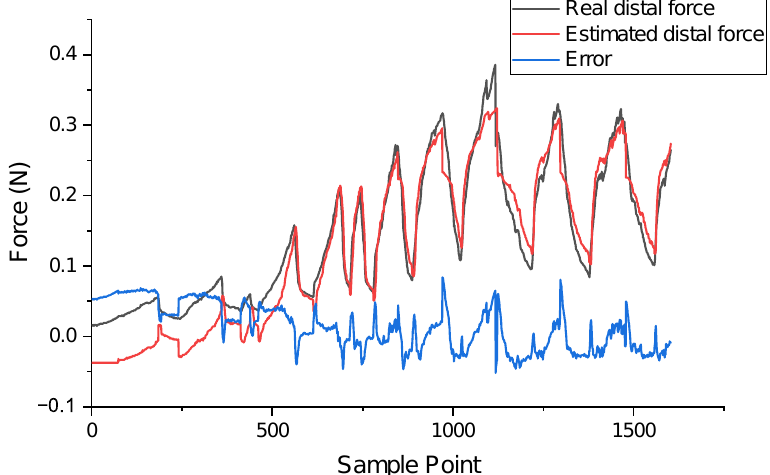
Figure 14. Test experiment with real-time force estimation. The black curve is measured by distal force sensor before the tube, and the red curve is the prediction result of the ANN. The trained neural network provides reasonable force estimates within about 50 mN